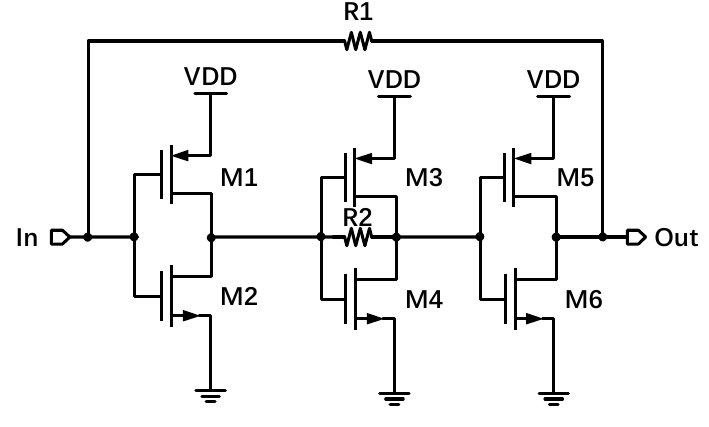
Figure 12. Schematic of TIA circuit.